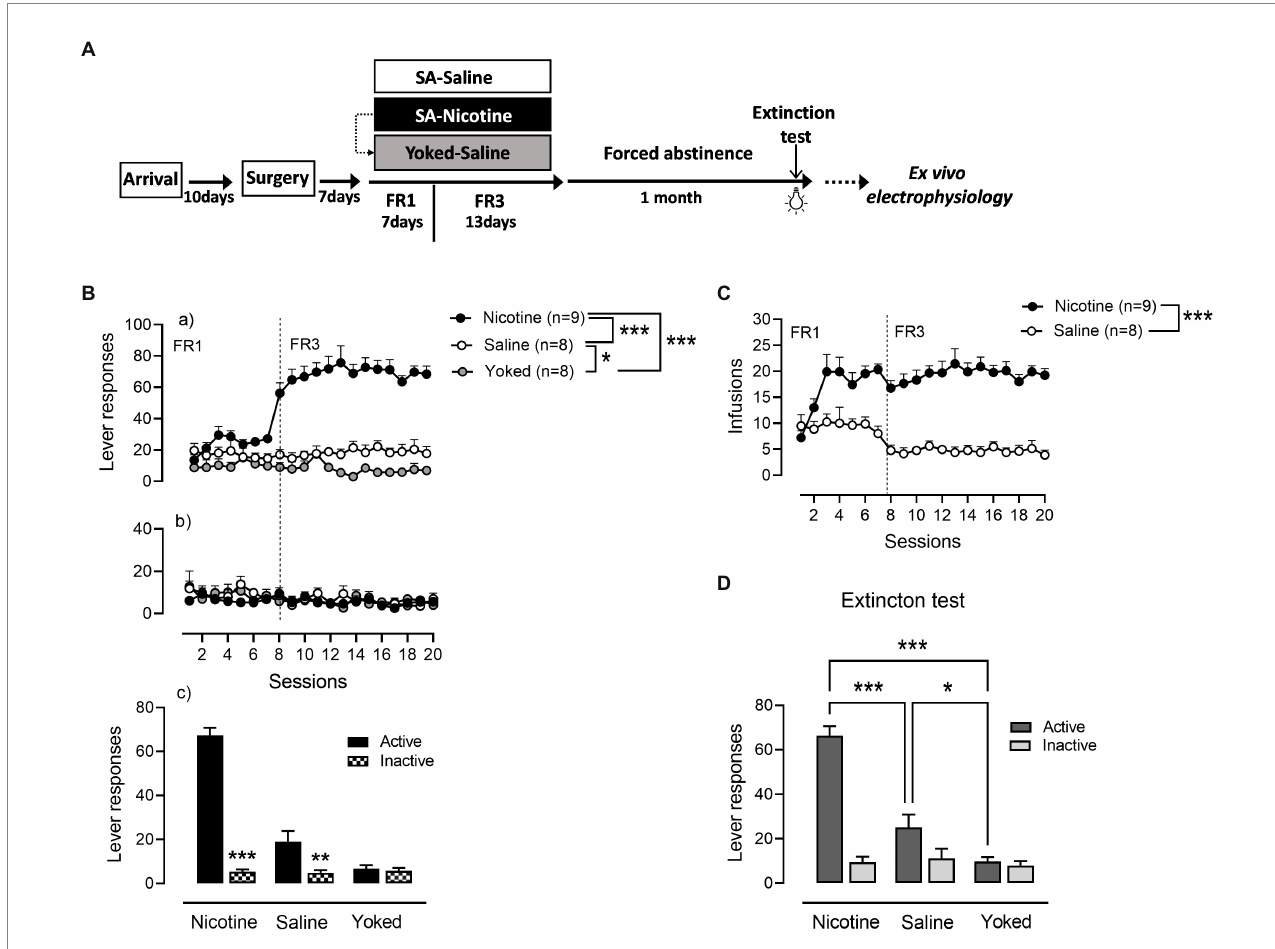
FIGURE 1 Cue-maintained responding during training and reinstatement in nicotine and saline self-administering rats. (A) Timeline of the experimental procedures that includes behavioral and neurophysiological assessments. (B) (a) During operant training nicotine-SA rats showed higher number of active lever presses over time compared to the control groups. Active responding for saline-SA rats was as well significantly higher than in yoked-saline control group. (b) Inactive lever pressing was very low with no differences between groups. (c) Both nicotine-SA and saline-SA rats discriminated between active and inactive lever presses while the yoked-saline group presented the same responding on both levers. (C) In accordance with the reported active lever presses, the number of infusions achieved over time was significantly higher in the rat self-administering nicotine compared to the saline-SA group. (D) Cue reinforced responding under extinction conditions 1 month after the last training session produced a significant higher operant responding in rats with a history of contingent nicotine-SA compared to saline-SA rats and yoked-saline control with the saline-SA group presenting higher active lever pressing than the yoked control, *** p < 0.001, ** p < 0.01, * p <